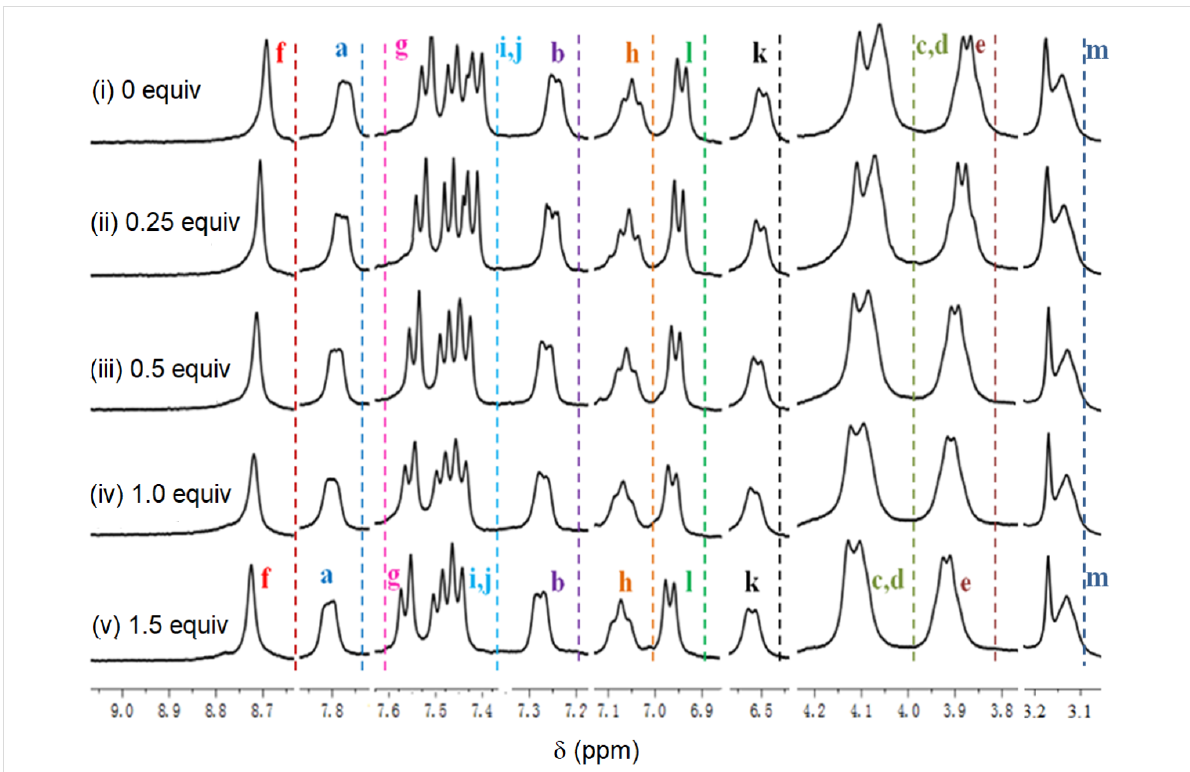
Figure 4: 1 H NMR spectra of 3 in the presence of Cr 3+ in DMSO- d 6 . (i) 3 . (ii) 3 + 0.25 equiv of Cr 3+ . (iii) 3 + 0.5 equiv of Cr 3+ . (iv) 3 + 1 equiv of Cr 3+ . (v) 3 + 1.5 equiv of Cr 3+